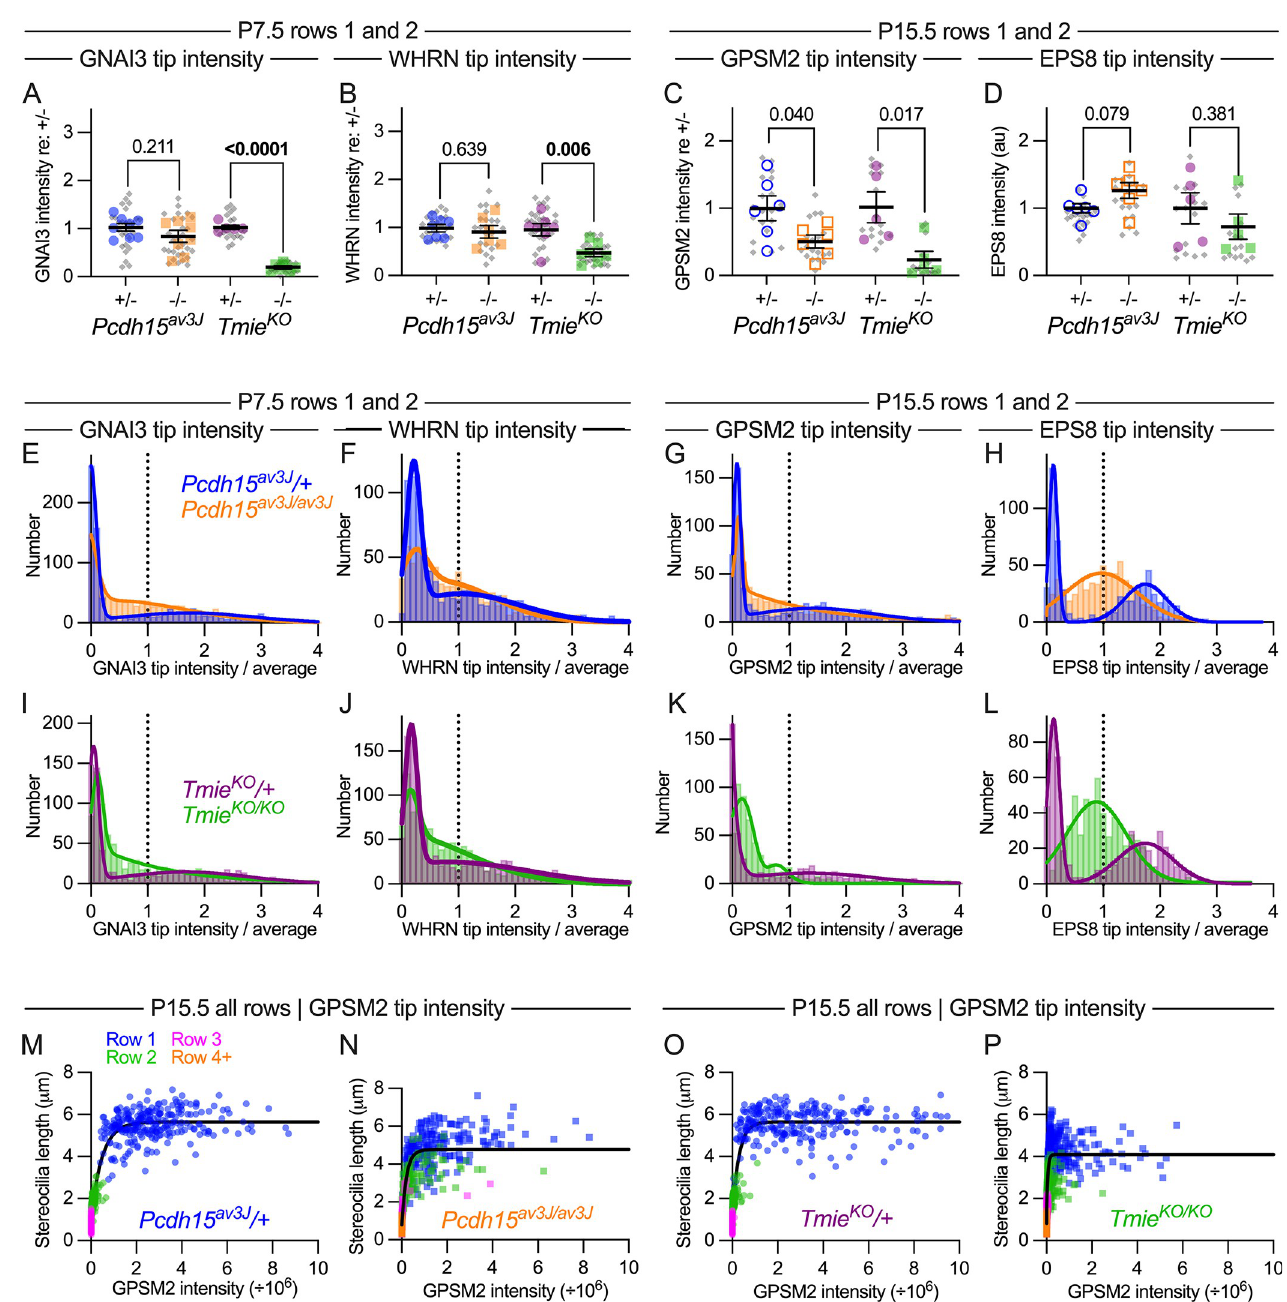
Fig 12. Distribution of GNAI3, GPSM2, and WHRN at tips of stereocilia in tip-link and transduction mutant IHCs. ( A, B ) GNAI3 (A) and WHRN (B) fluorescence average intensity per hair bundle for all measured stereocilia (rows 1 and 2) for Pcdh15 av3J and Tmie KO hair cells at P7.5. Plotting and statistical testing were as in Fig 3. ( C, D ) GPSM2 (C) and EPS8 (D) fluorescence average intensity per hair bundle for all measured stereocilia (rows 1 and 2) for Pcdh15 av3J and Tmie KO hair cells at P15.5. ( E, F ) Frequency distribution of GNAI3 and WHRN tip intensity in Pcdh15 av3J hair cells at P7.5. ( G, H ) Frequency distribution of GPSM2 and EPS8 tip intensity in Pcdh15 av3J hair cells at P15.5. ( I, J ) Frequency distribution of GNAI3 and WHRN tip intensity in Tmie KO hair cells at P7.5. ( K, L ) Frequency distribution of GPSM2 and EPS8 tip intensity in Tmie KO hair cells at P15.5. Tip intensities were from all rows 1 and 2 stereocilia; distributions were fit with double Gaussian functions. ( M–P ) Correlation of normalized GPSM2 intensity with stereocilia length. Data from individual rows were displayed with separate symbol colors but all data were used for fits; data were fit with y = a + b • exp(- k • x ), where y is stereocilia length, x is GPSM2 intensity, and a , b , and k are constants. The data underlying all the graphs shown in the figure can be found in figshare (https://doi.org/10.6084/m9.figshare. 21632636.v2). IHC, inner hair